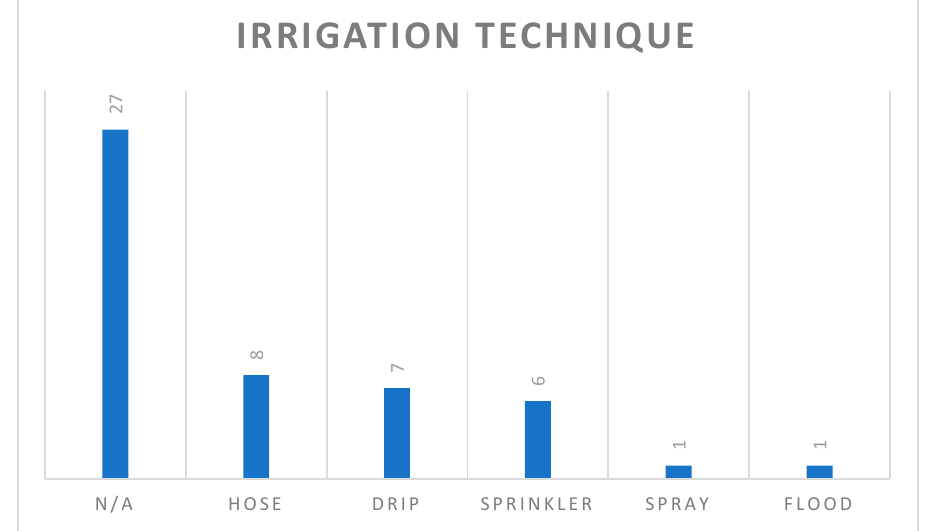
Figure 9. Irrigation techniques. Table 6. A list of publications by irrigation method. Irrigation